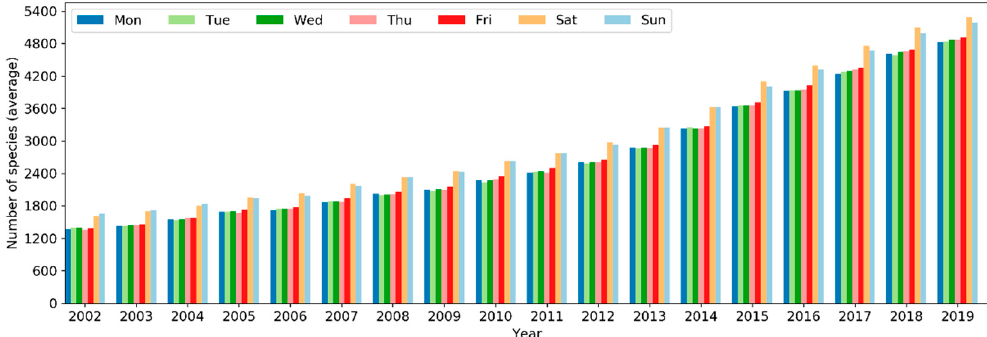
Figure 18. Average number of species reported on each day of the week over the years.